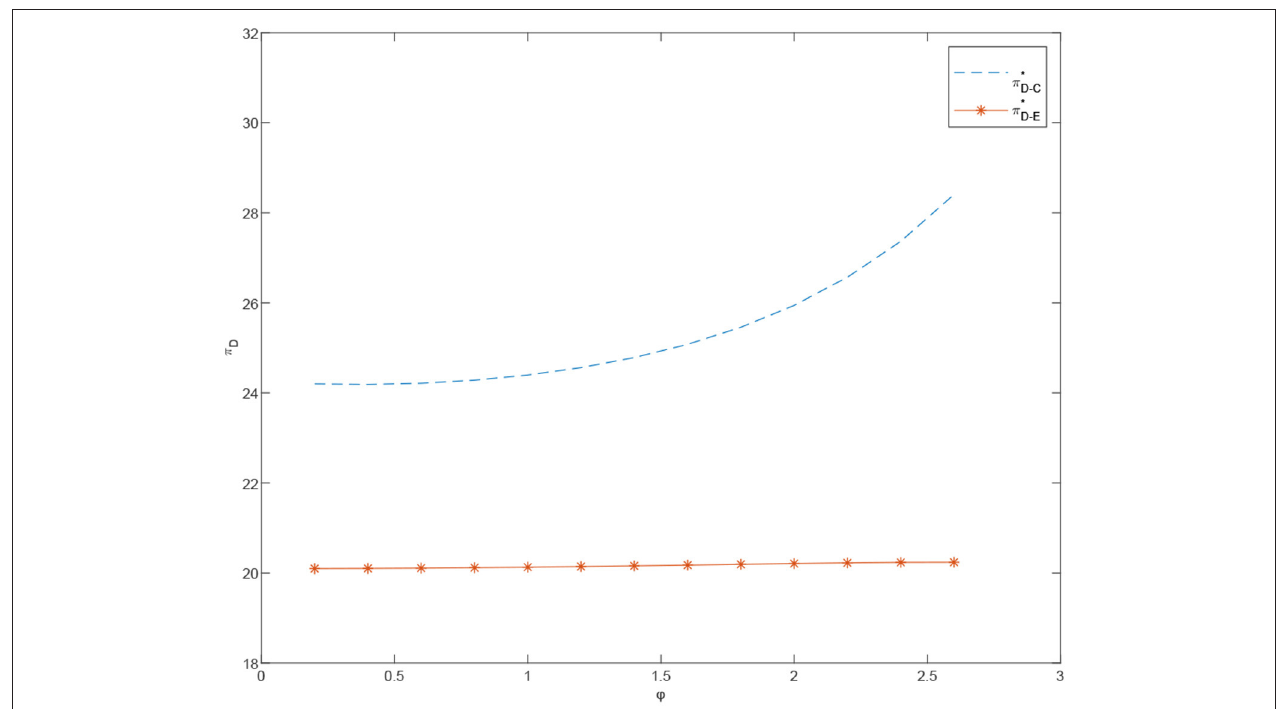
FIGURE 8 | The effects of ϕ on the prices under the centralized scenario, p ∗ e − C and p ∗ m − C .